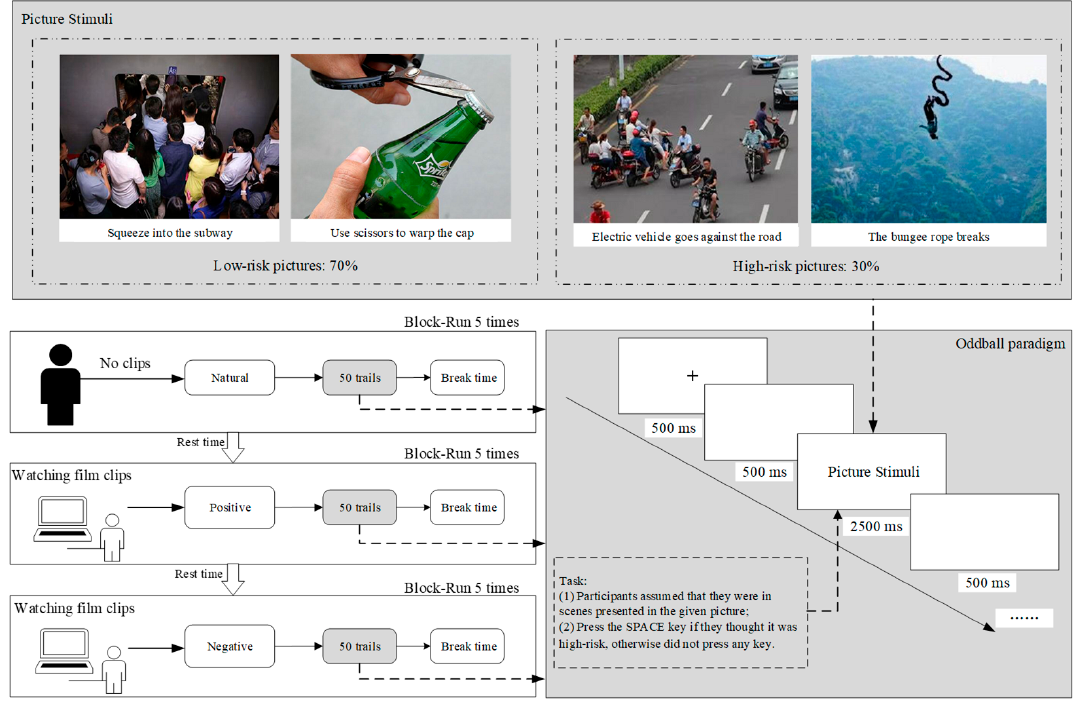
Figure 1. Experimental procedure.